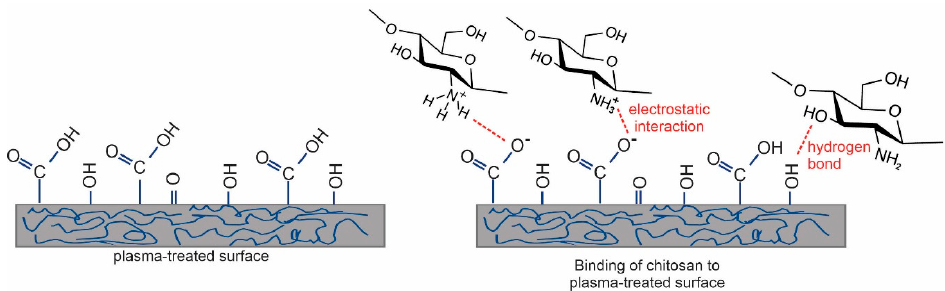
Figure 10. Different types of interaction of chitosan with the plasma-treated surface.